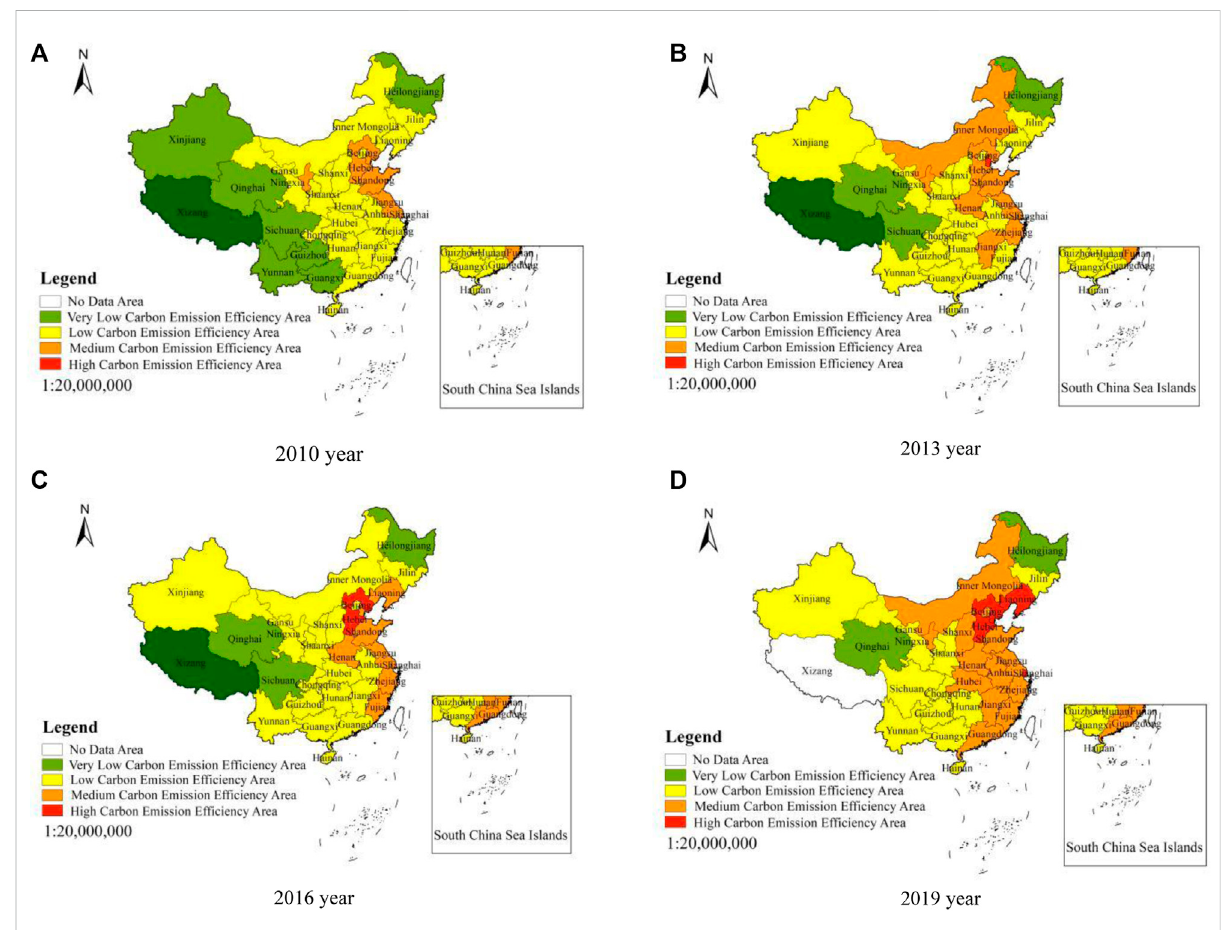
FIGURE 3 Distribution of carbon emission ef fi ciency rating differences of logistics industry in 30 provinces in China, 2010 –